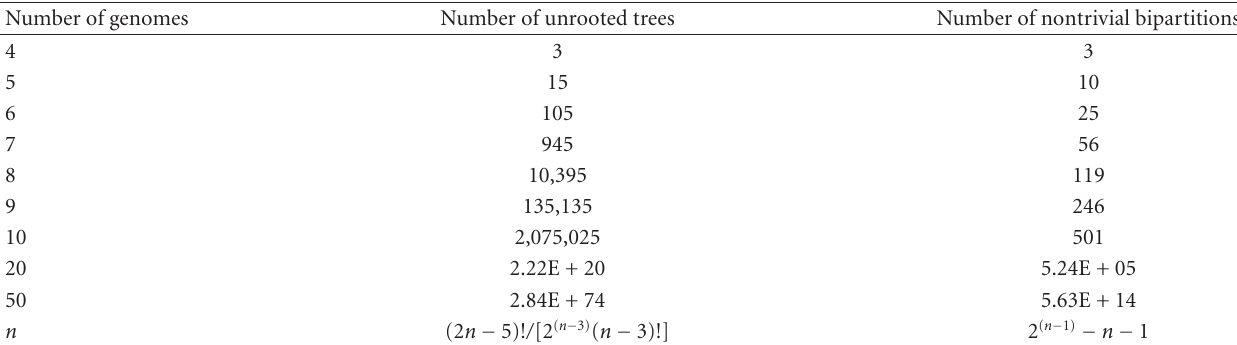
Table 1: Number of possible trees and bipartitions given a fixed set of